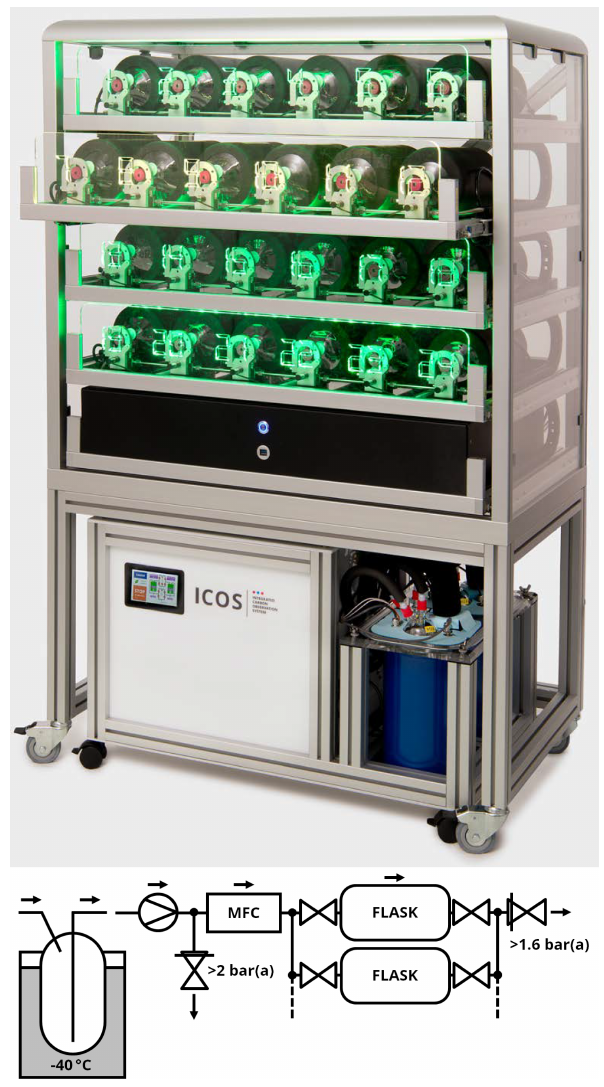
Figure 2. Photograph of the ICOS flask sampler with a schematic flow